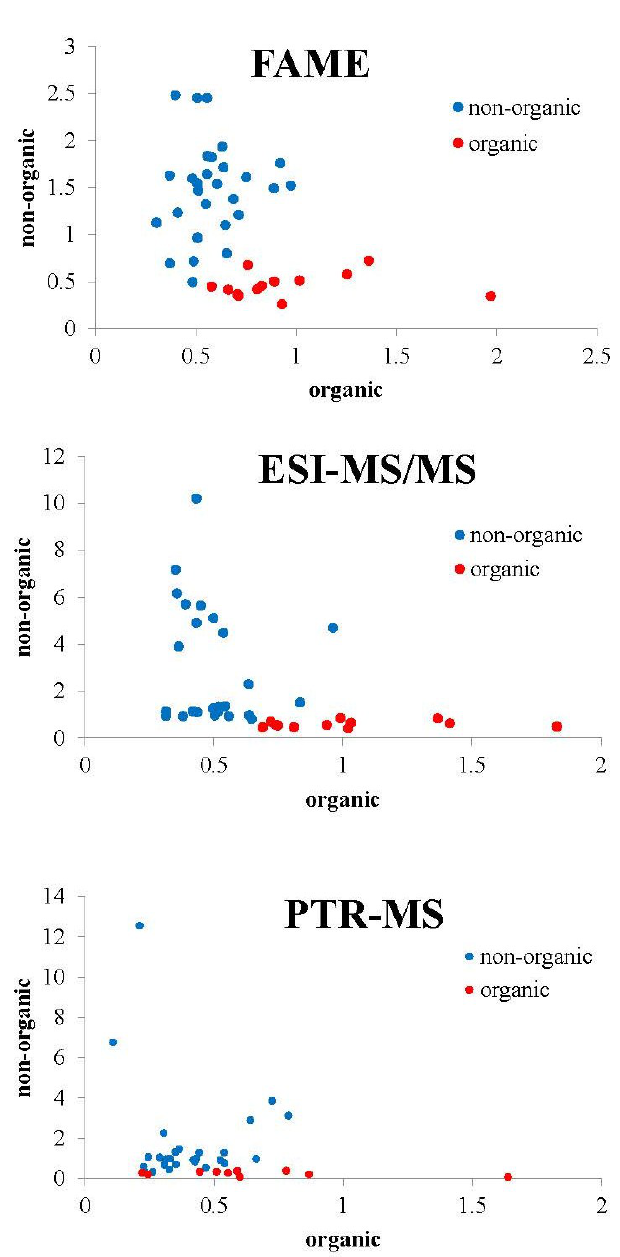
Figure 2. Graphical representation of sample distance to each class of the SIMCA models for samples of pork belly meat from the categories non-organic (conventional + free range) and